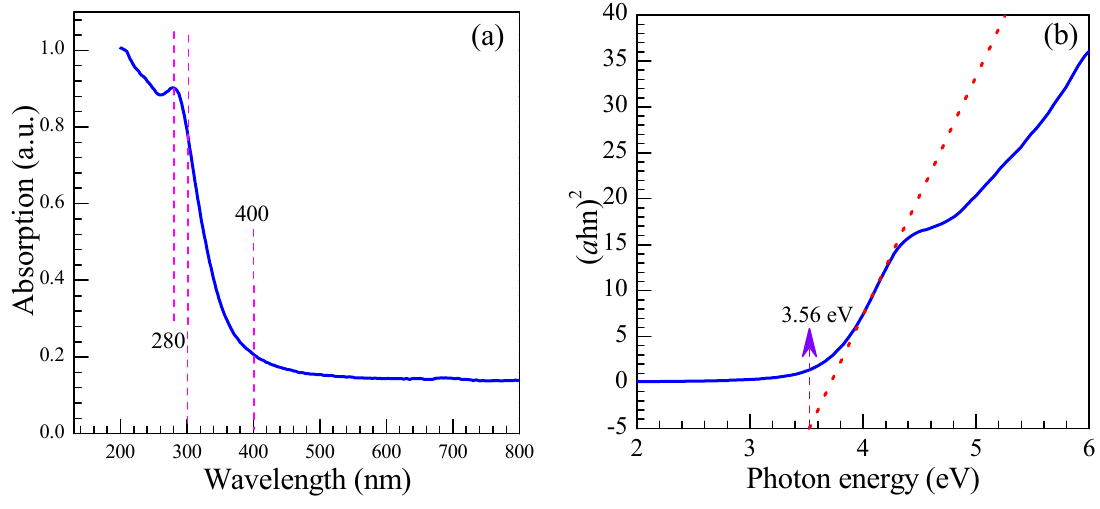
Figure 8. ( a ) UV–VIS diffuse reflectance spectrum of as-prepared SnO 2 nanosheets and ( b ) ( α h v ) 2 – h v photon energy curve.